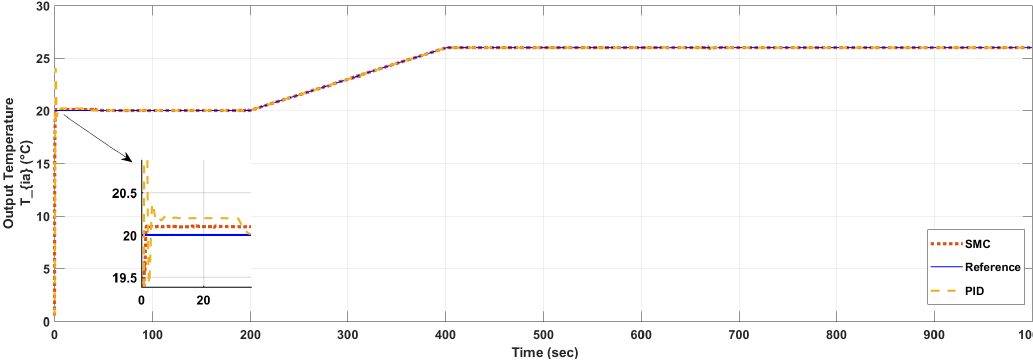
Figure 7. Output temperature response of controllers while tracking sequence of steps and ramp reference.